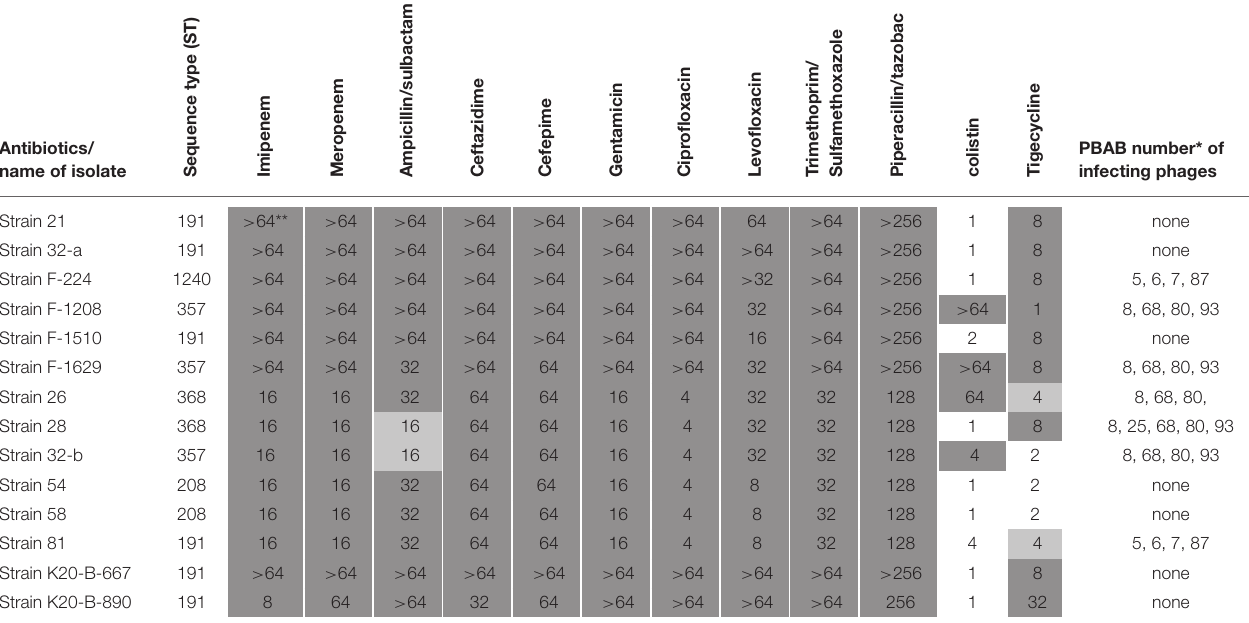
TABLE 1 | Antibiotic resistance profile of clinically isolated Acinetobacter baumannii strains and their phage susceptibility.